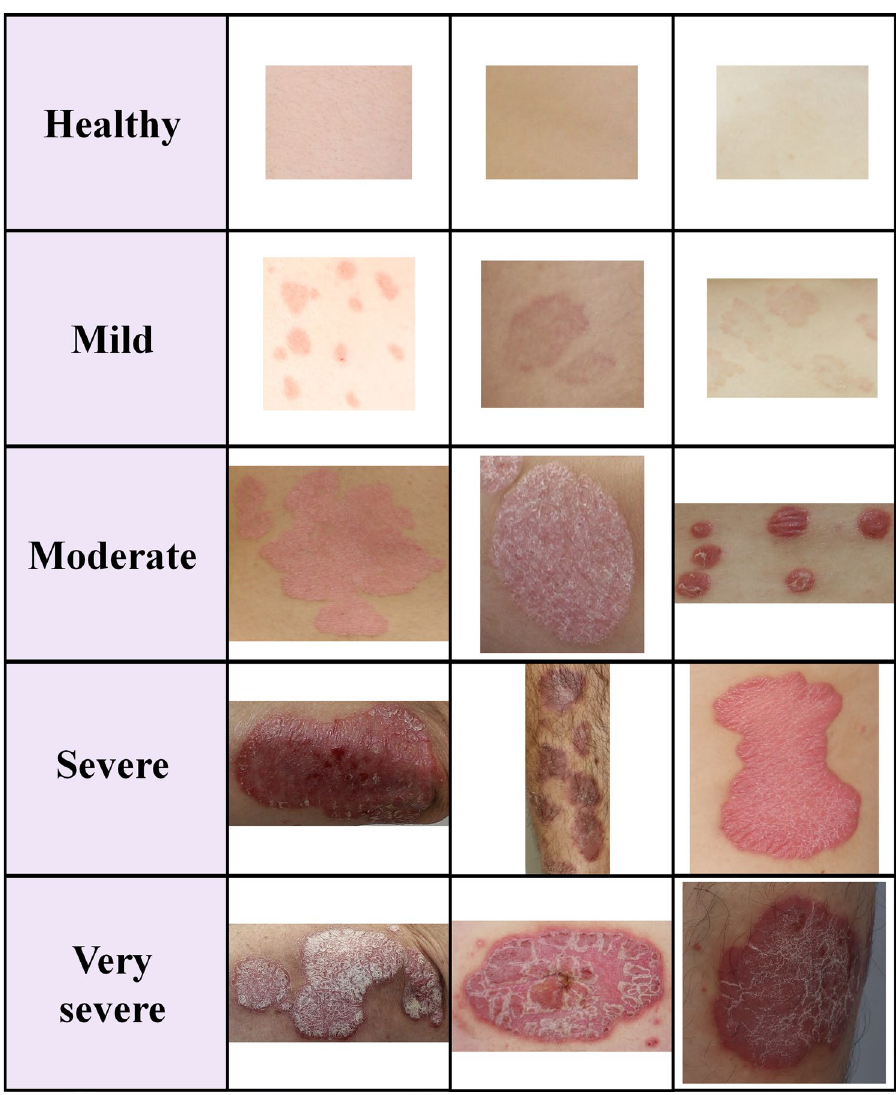
Figure 4. Representative images of psoriatic disease for a total of five severity groups. Healthy skin is normal skin, where no lesions exist. From mild to very severe, they are images classified based on the scoring value, which is the sum of PASI parameters (erythema, scaling), by the clinician. Images have random sizes owing to the body parts and lesion shape, size, etc.